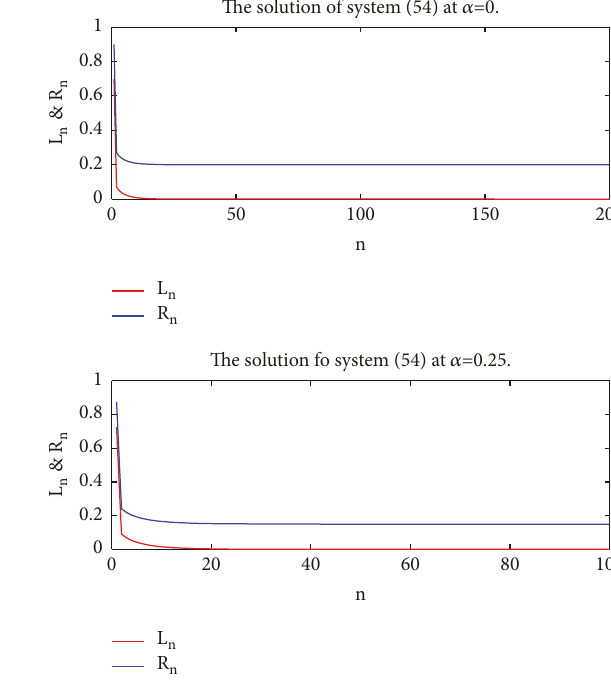
Figure 3: The solution of system (53) at 𝛼 = 0.75 and 𝛼 = 1.